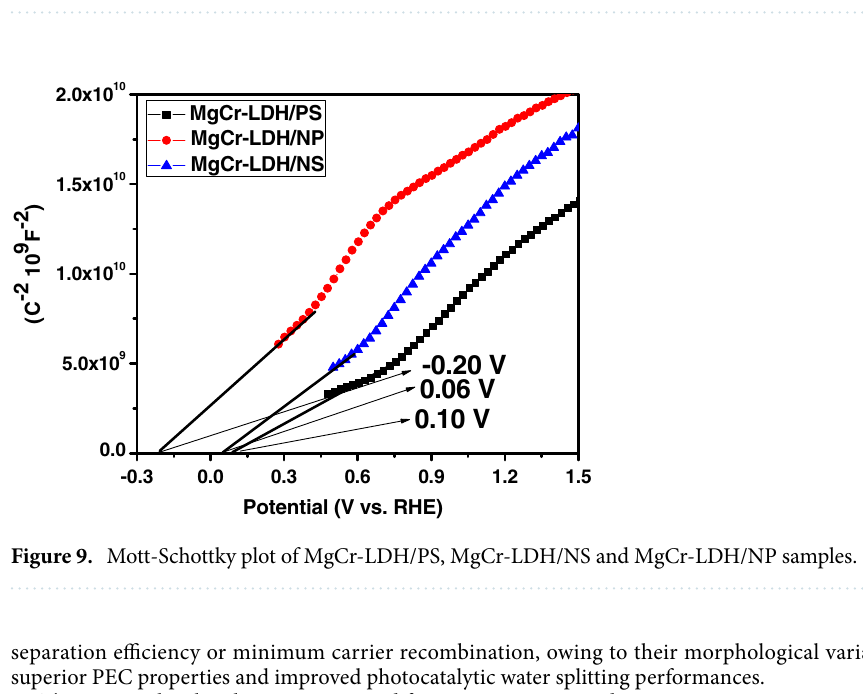
Figure 8. Bode Phase Plot of MgCr-LDH/PS, MgCr-LDH/NS and MgCr-LDH/NP.